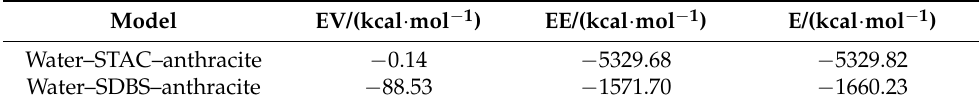
Table 2. Adsorption energy between water and raw or modified anthracite